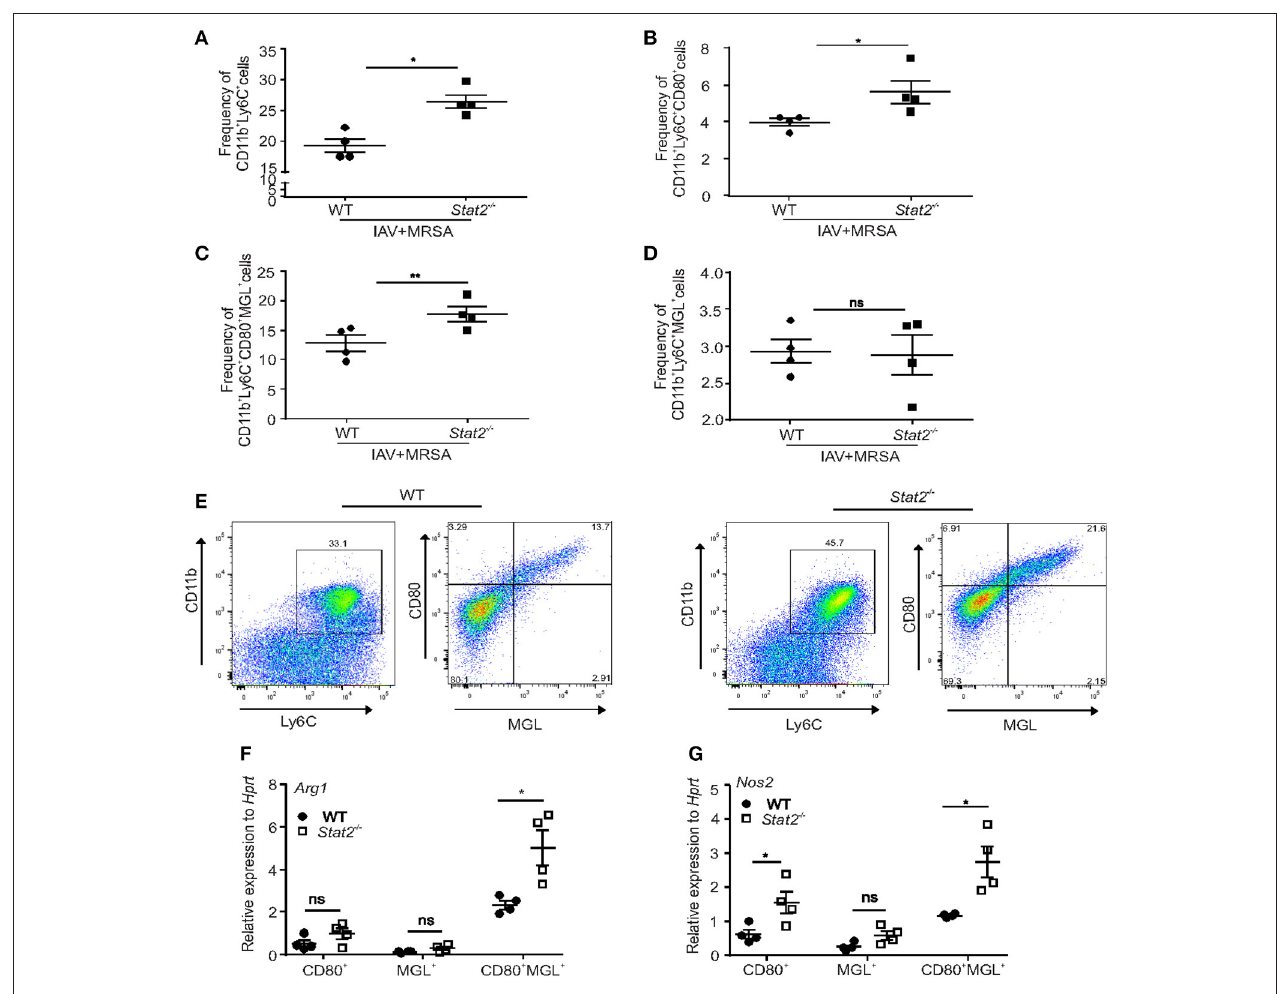
FIGURE 4 | Increased frequency of M1/M2 macrophages in Stat2 − / − during influenza-MRSA super-infection. WT or Stat2 − / − mice were infected with 100 PFU of influenza for 6 days then challenged with 5 × 10 7 cfu of MRSA for one additional day. (A) Frequency of CD11b + Ly6C + cells, (B) CD11b + Ly6C + CD80 + cells, (C) CD11b + Ly6C + MGL + cells (D) CD11b + Ly6C + CD80 + MGL + cells from lungs were determined from influenza and MRSA super infection by flow cytometry, N =